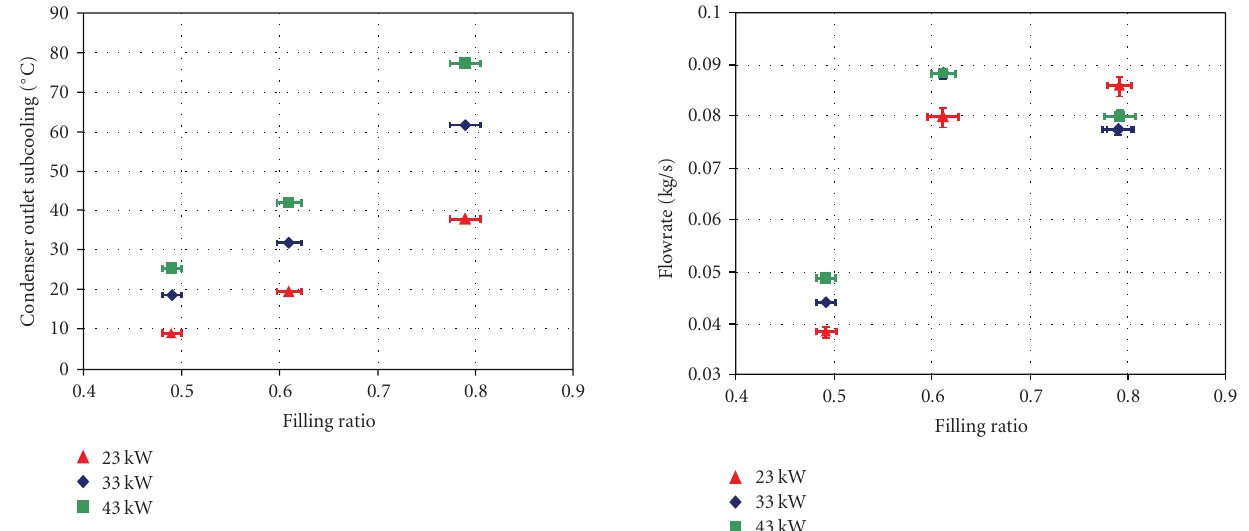
Figure 5: E ff ects of filling ratio and electrical power on system flowrate (without heat losses compensation)